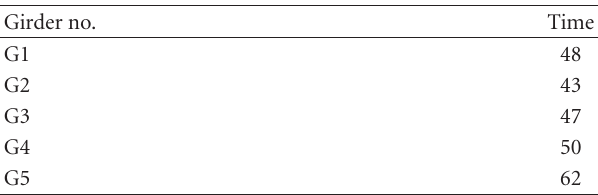
Table 7: Time (year) to “ P ” state of fatigue bu ff ers. Girder